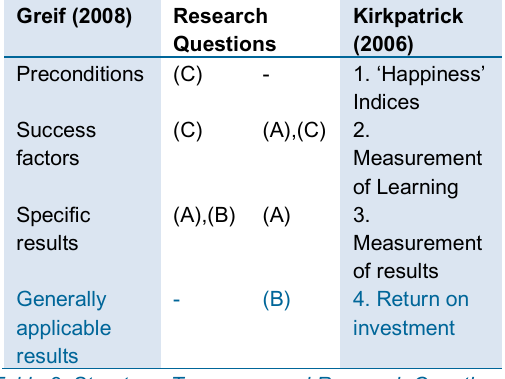
Table 2: Structure, Taxonomy and Research